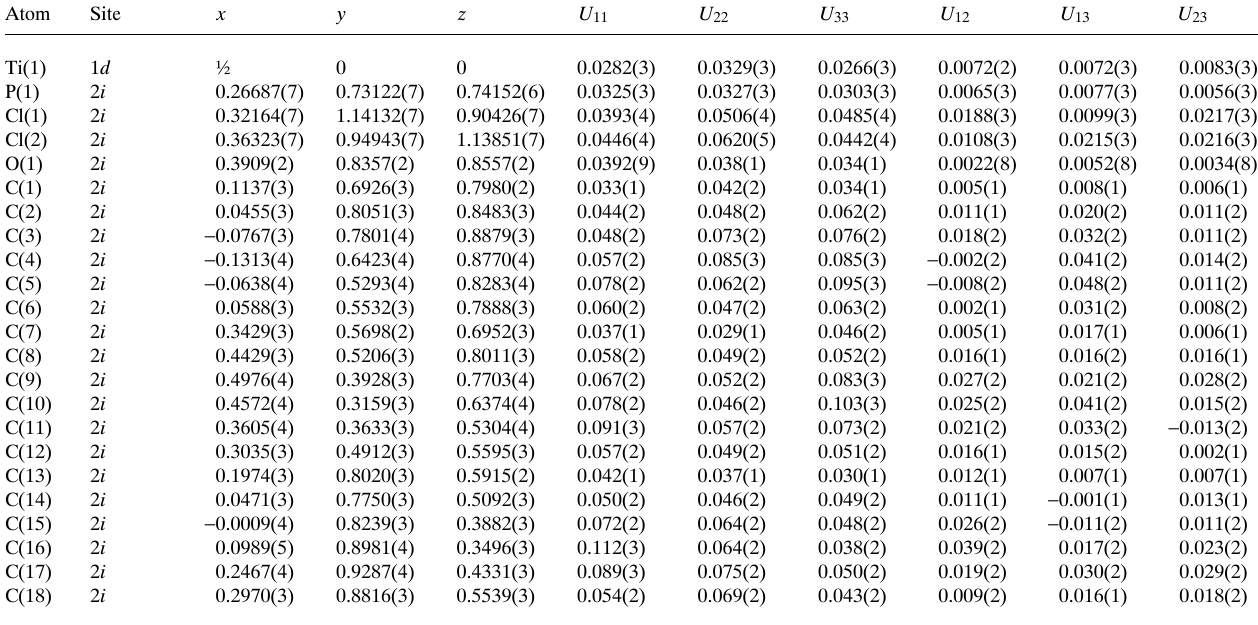
Table 3. A tomic coordin a tes a nd displ a cement p a r a meters (in Å 2 )